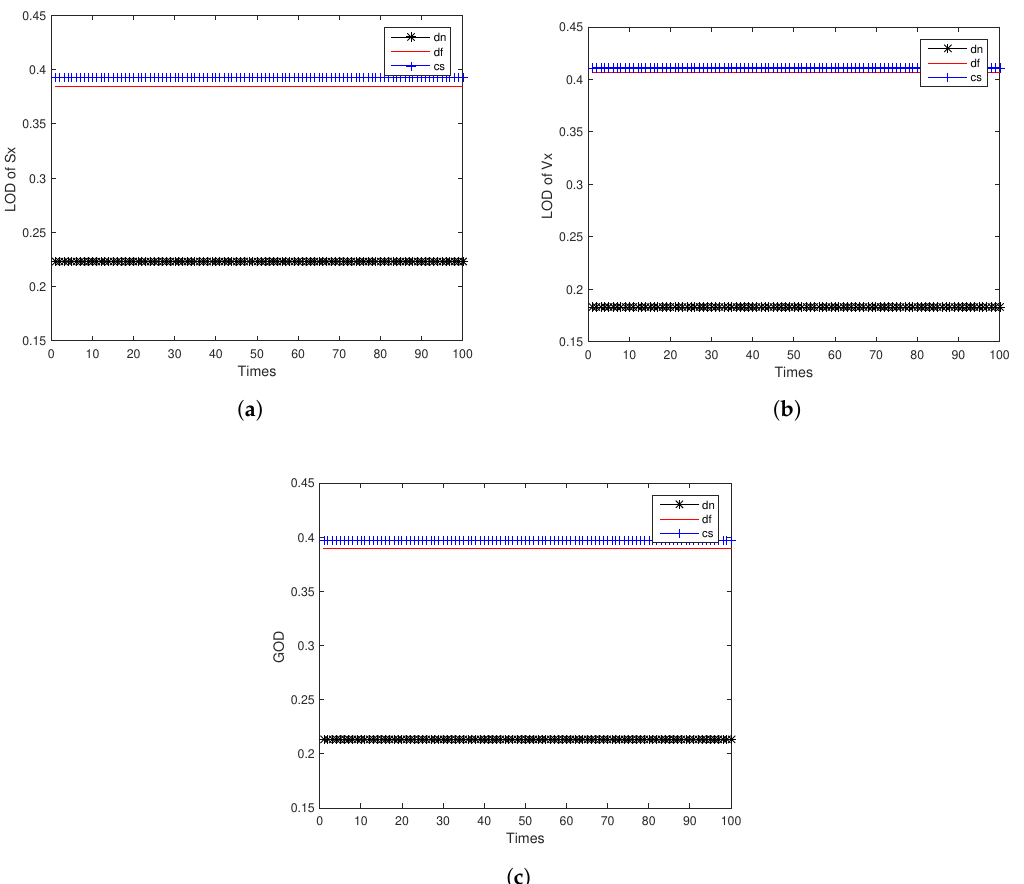
Figure 8. Observable degree comparison among different fusion methods for same index 2: ( a ) LOD of Sx; ( b ) LOD of Vx; ( c ) GOD.